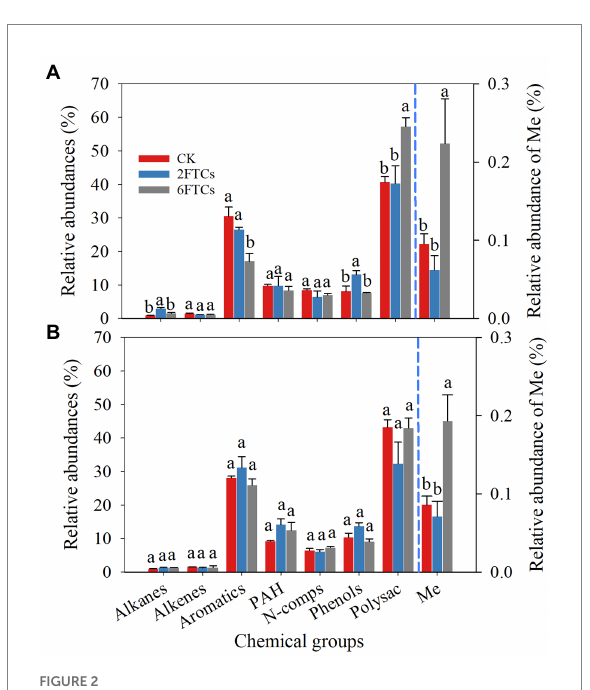
FIGURE 2 Relative abundances of 8 chemicals groups of DOM in different freeze–thaw cycles. (A) 0–10 cm; (B) 50–60 cm. PAH, Polyaromatics; N-comps, N-compounds; Polysac, Polysaccharide compounds; Me, Fatty acid methy esters. CK, 2FTC, and 6FTC represent cultured at 5 ° C, freeze–thaw treatment of 2 cycles and 6 cycles, respectively. The relative abundances of Me are represented on the right axis. Different lowercase letters indicate significant differences within each freeze–thaw treatment ( p <